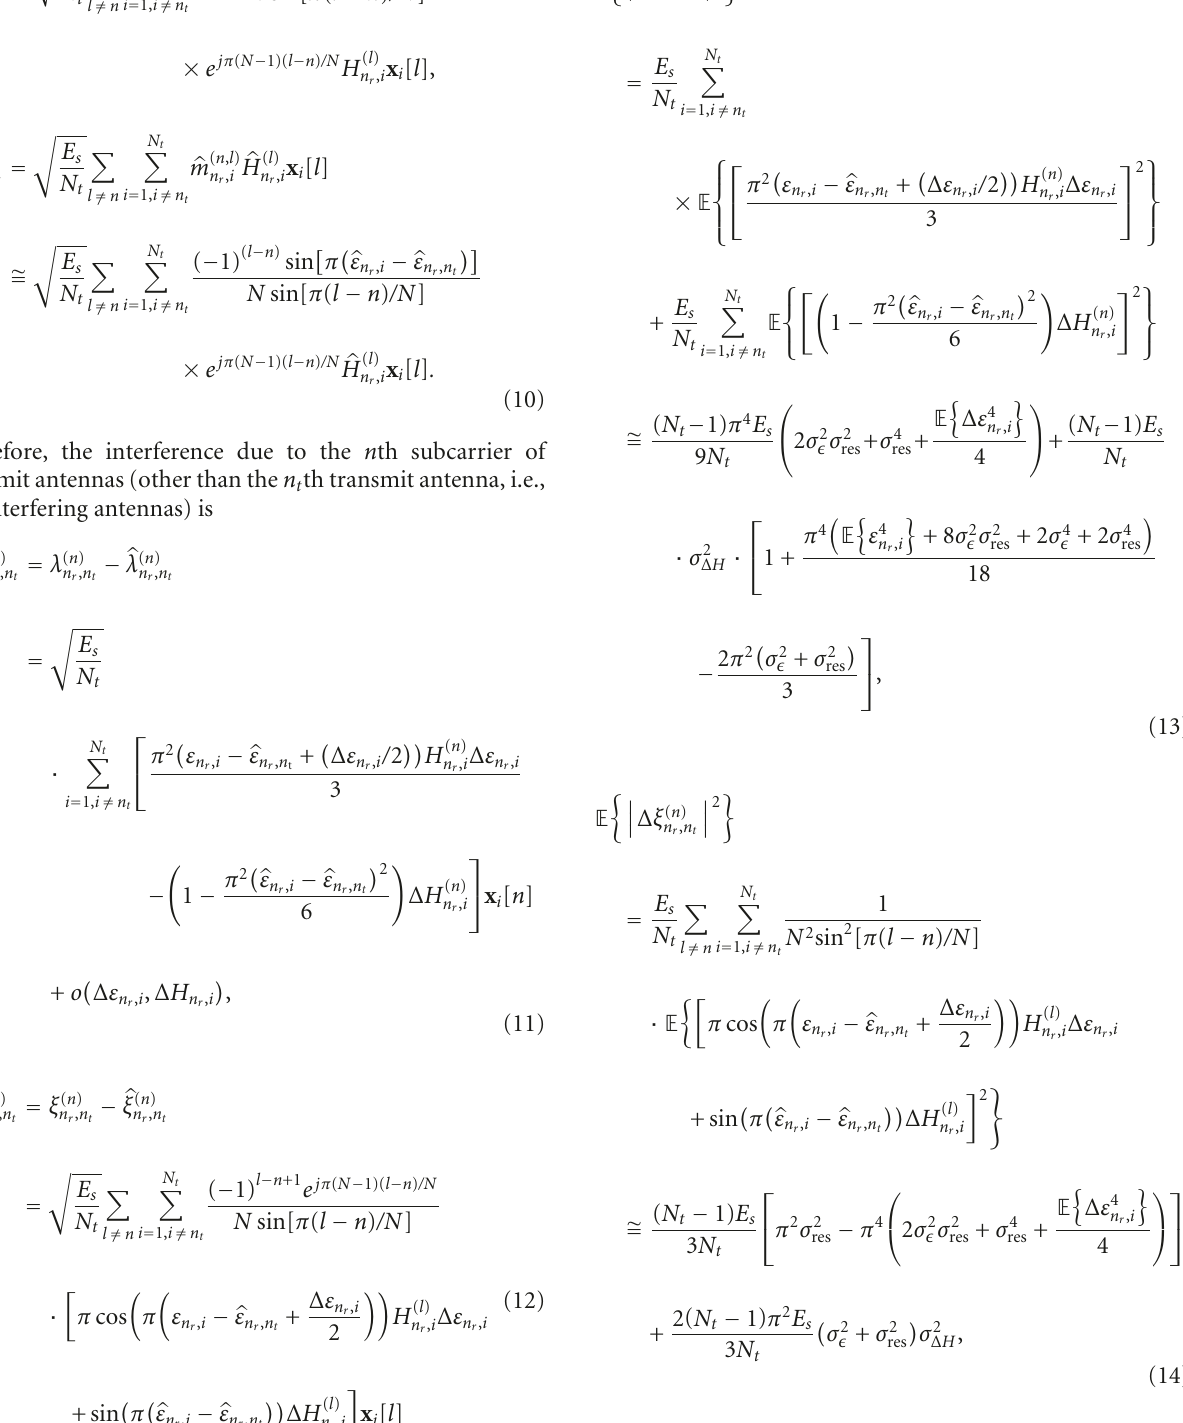
respectively. After averaging out frequency o ff set ε n frequency o ff set estimation error Δ ε n tion error Δ H ( n ) n for all ( n r , n t ), the average SINR of r n r , n t